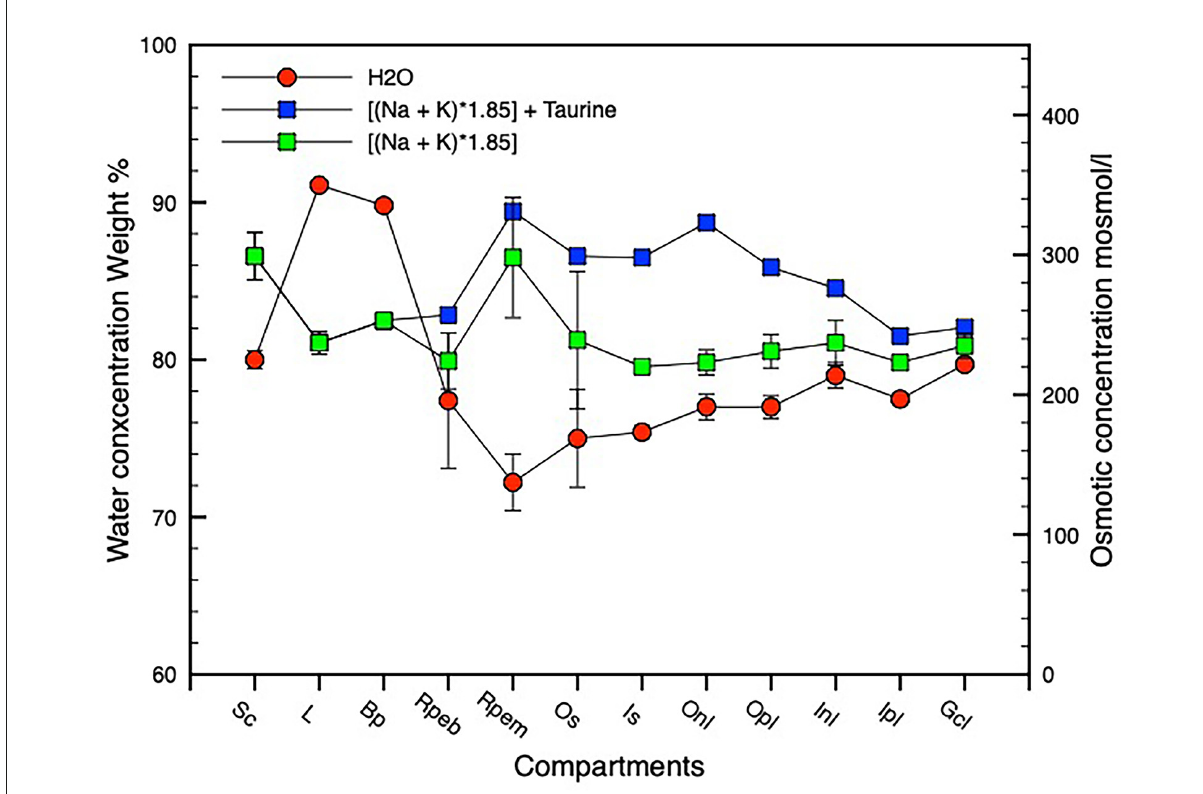
FIGURE9 Graph showing water and osmotic concentration gradients across the retinal complex. n = 3, SD error bars. An osmotic gradient is shown assuming that taurine acts as an osmolyte using taurine concentration values derived from taurine data in Orr et al. (1976). n = 3, SD error bars. Compartment abbreviations on X-axis as in Figure 3A